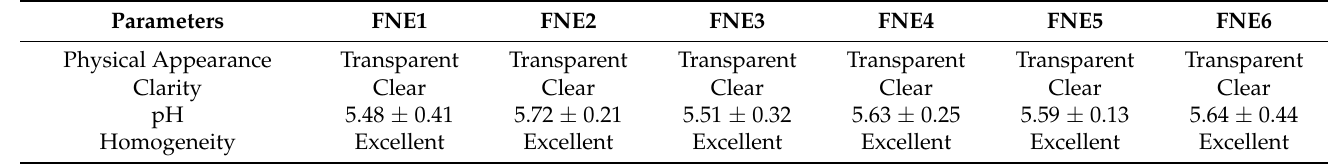
Table 2. Organoleptic analysis of prepared nanoemulsion formulations (FNE1–FNE6).